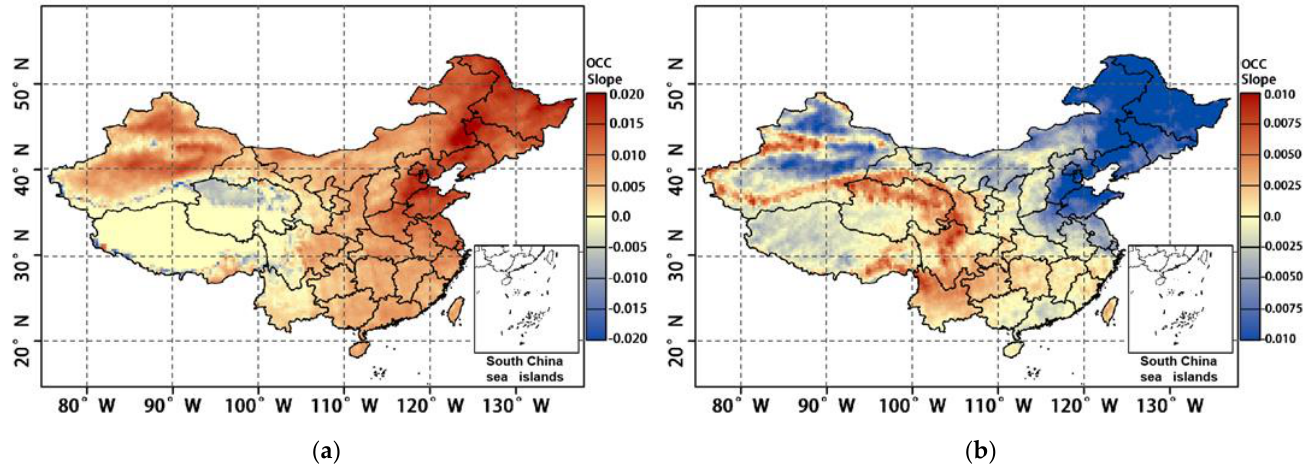
Figure 9. Slope results for OCC: ( a ) OCC slope of 0 – 3 km; ( b ) OCC slope of 3 – 5.8 km. Table 4. Correlation coefficient of the OCC slope at different altitudes and at 3 – 5.8 km.